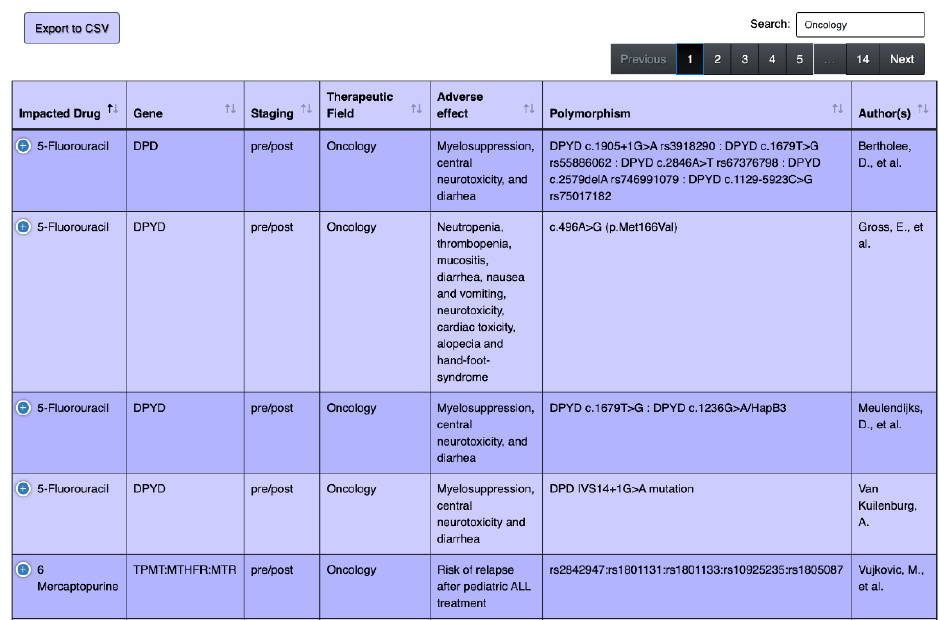
Figure 3. Screenshots of the web-based search tool of pharmacogenetics table, searching for drugs related to the field of oncology. The background color is the same as the actual website, color variation is for row separation purpose.